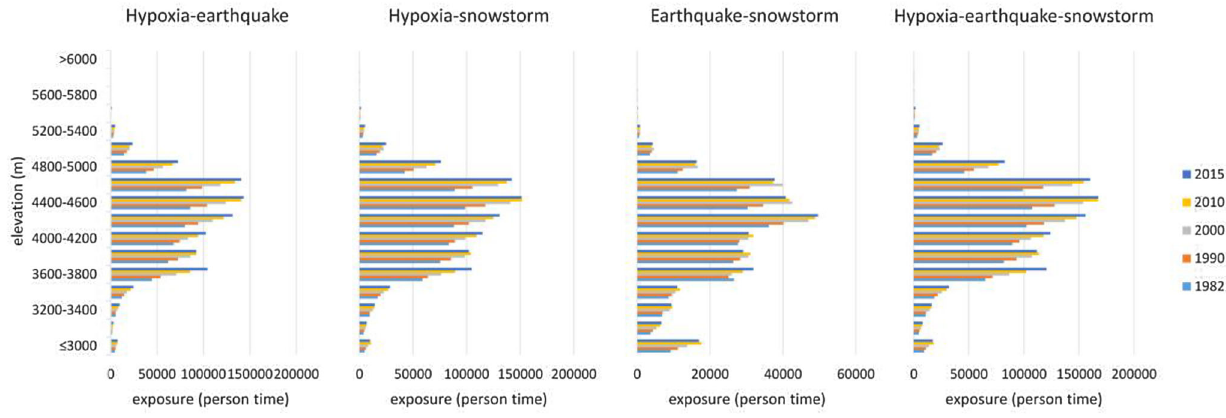
Fig. 5 Person (cid:2) time exposure to each multi-hazard combination by elevation range and time period in